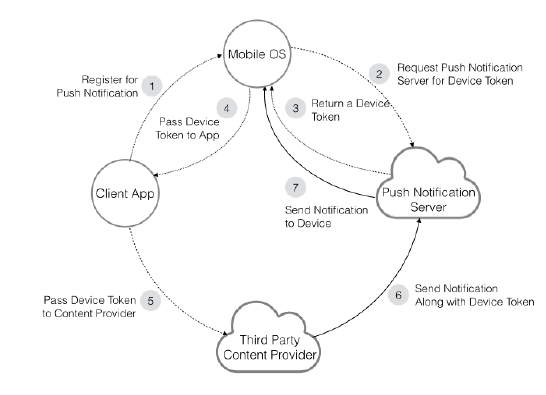
Figure 2: Architecture of Push Notification